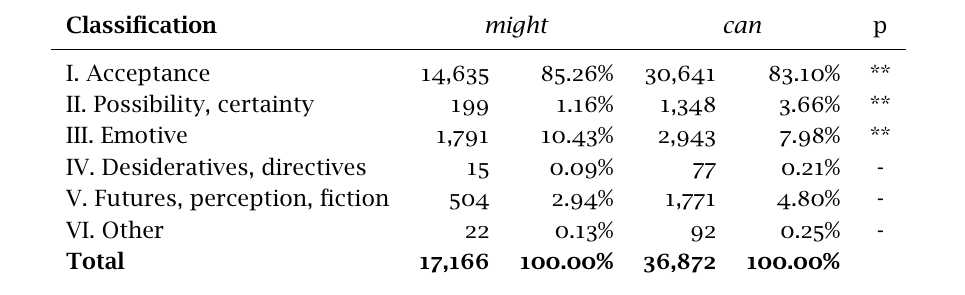
Distribution of might and can across attitude contexts: ** p < 0 . 001 , - p > 0 . 05 , Fisher’s exact test. Compares the distribution of might and can in each class to their respective distribution in matrix declaratives ( might 75 , 526 , can 267 , 130